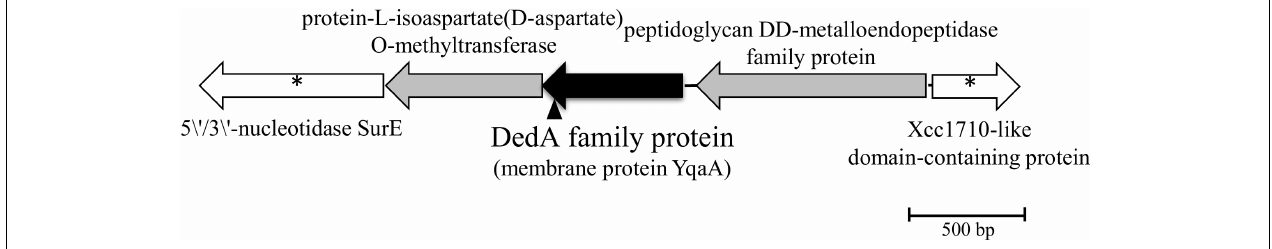
FIGURE 1 | Physical map of interrupted gene from strain B2A1Ga4, identified by IPCR. Transposon insertion into yqaA gene is indicated by the vertical arrowhead. The sequences marked with ∗ are sequences obtained by the draft genome sequencing of